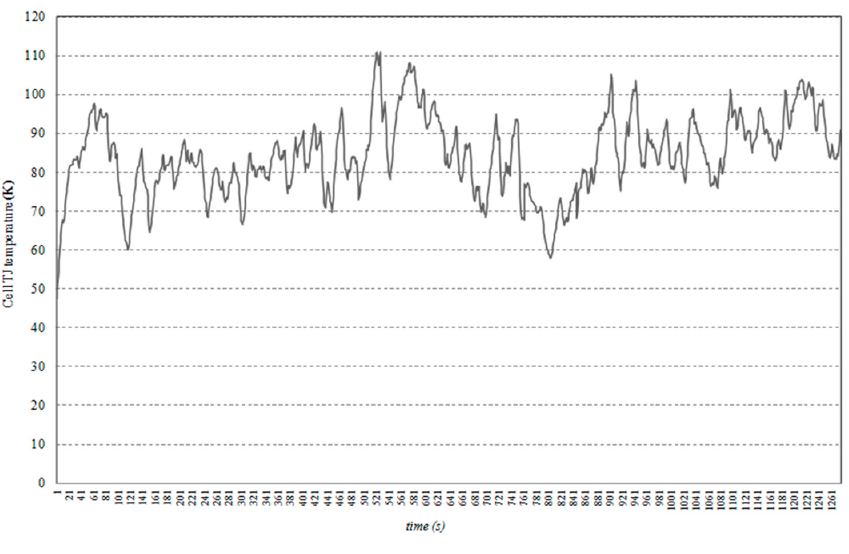
Figure 8. Experimental trend of the TJ cell temperature.